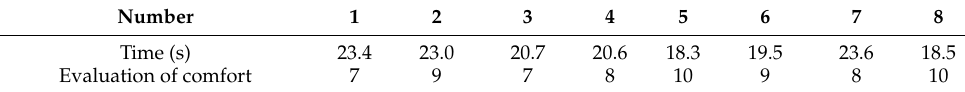
Table 6. Data of Experiment 2 (Combination of three